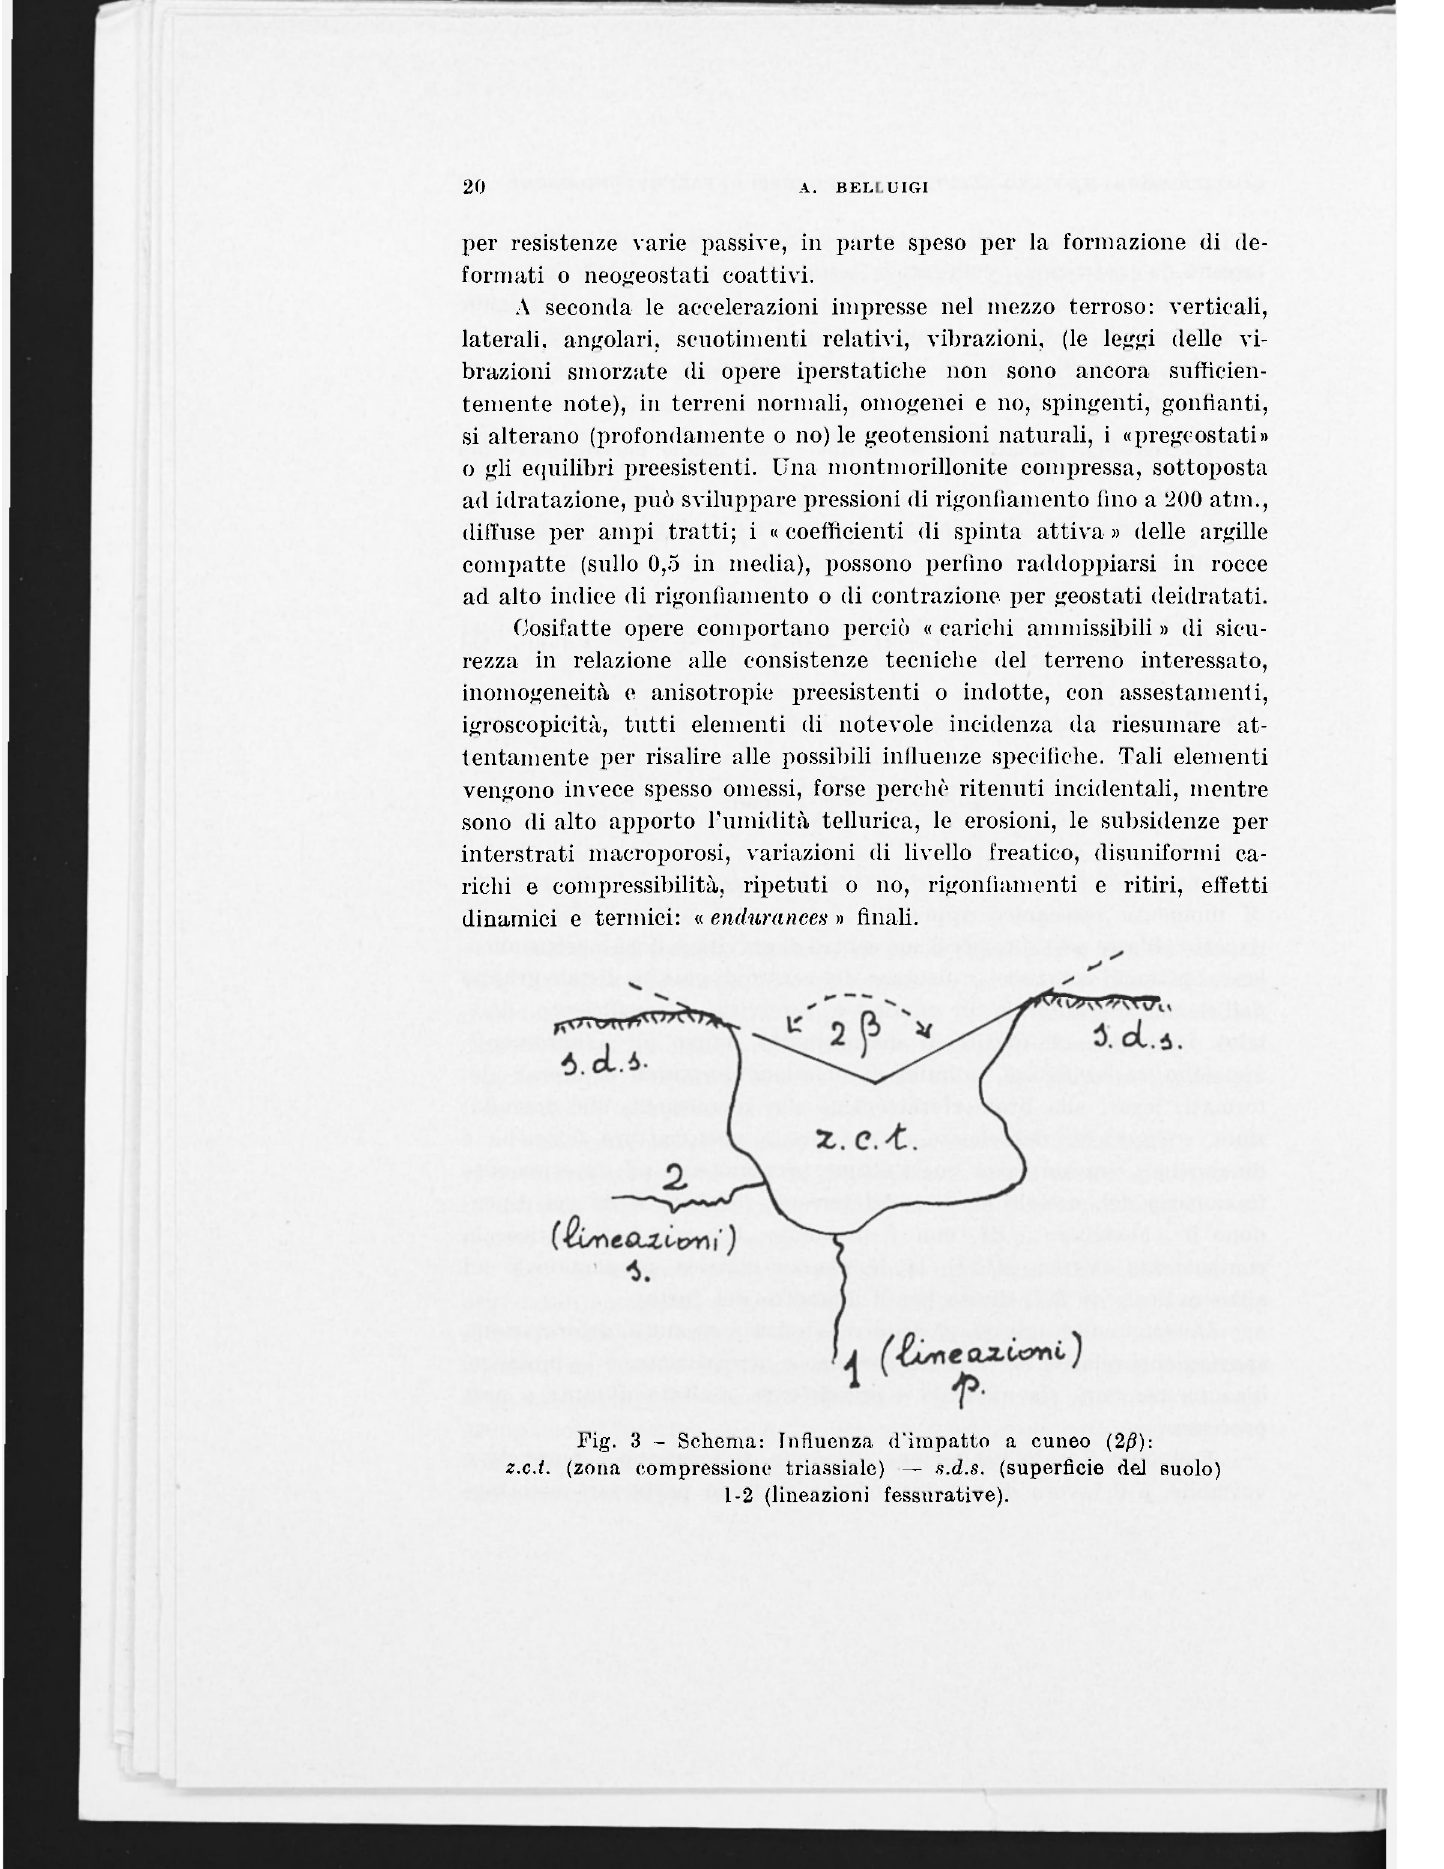
Fig. 3 - Schema: Influenza d'impatto a cuneo (2/?): z.c.t. (zona compressione triassiale) — s.d.s. (superficie del suolo) 1-2 (lineazioni